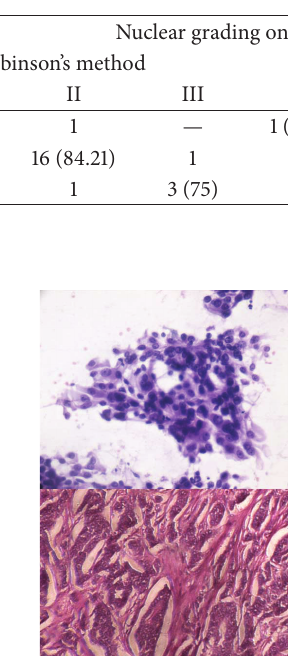
Table 3: Correlation of Nottingham modification of Scarff-Bloom-Richardson method on histopathology with two cytological nuclear grading methods.